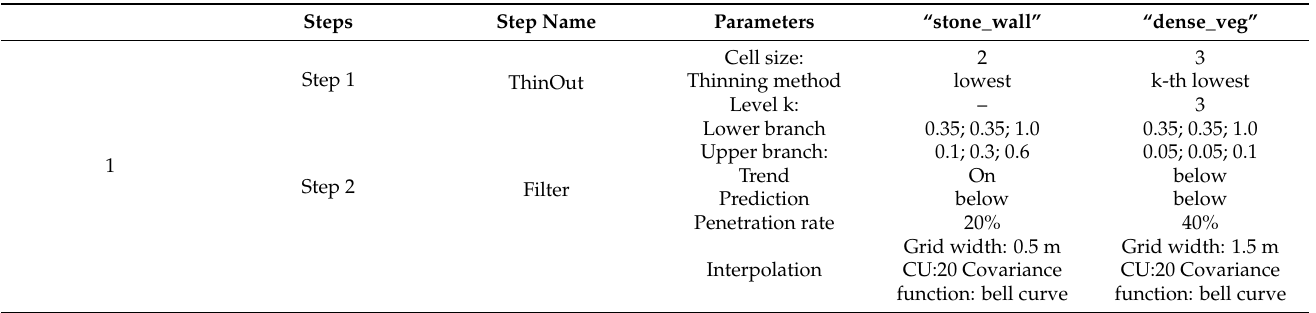
Table 2. Filter steps and relevant parameters for both filter strategies defined within the framework of